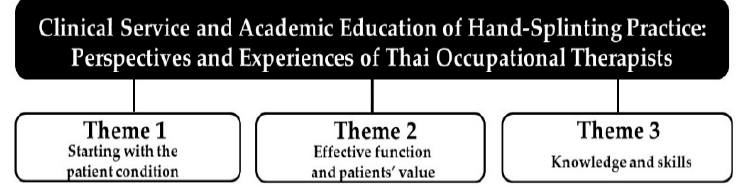
Figure 3. Summary of main themes.